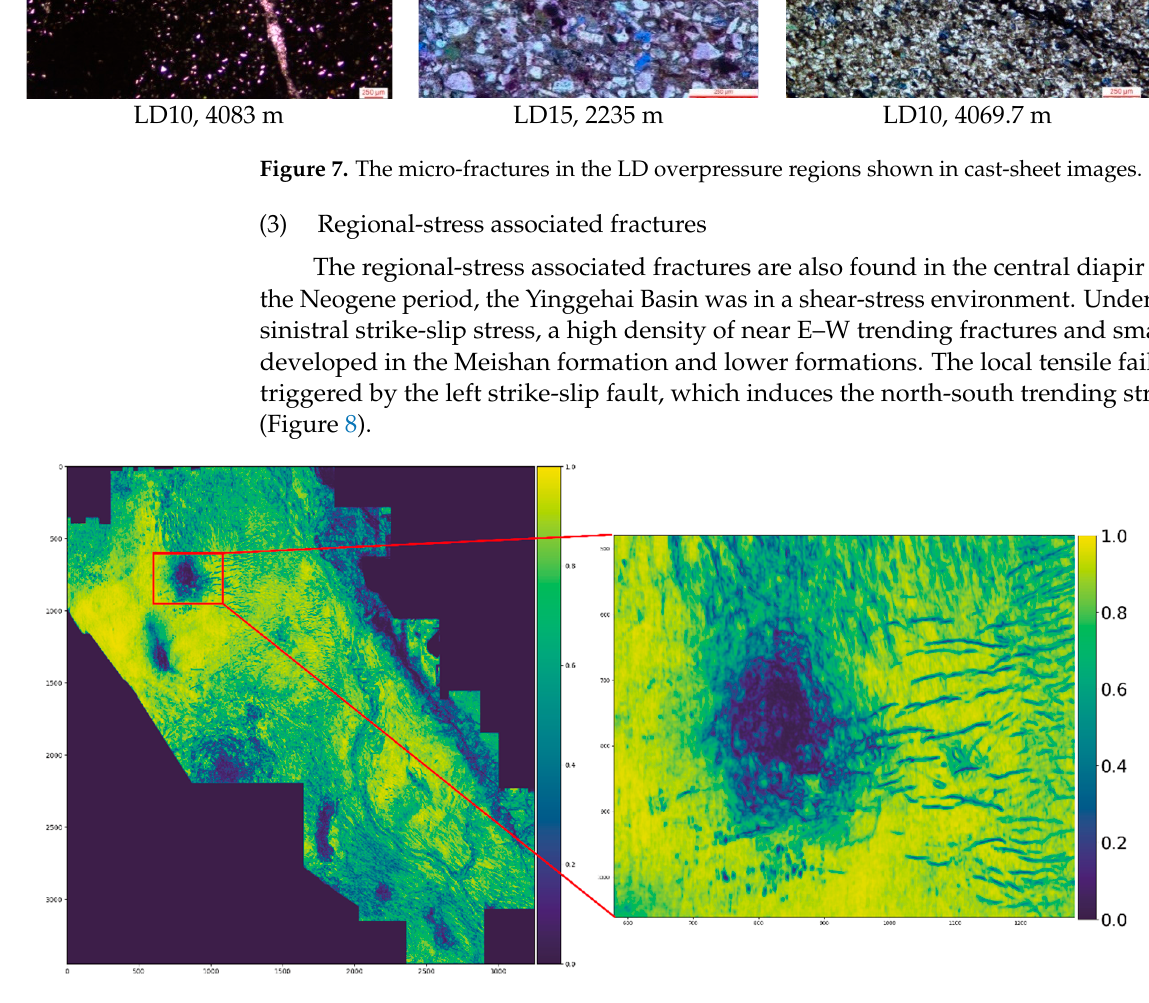
Figure 7. The micro-fractures in the LD overpressure regions shown in cast-sheet images.